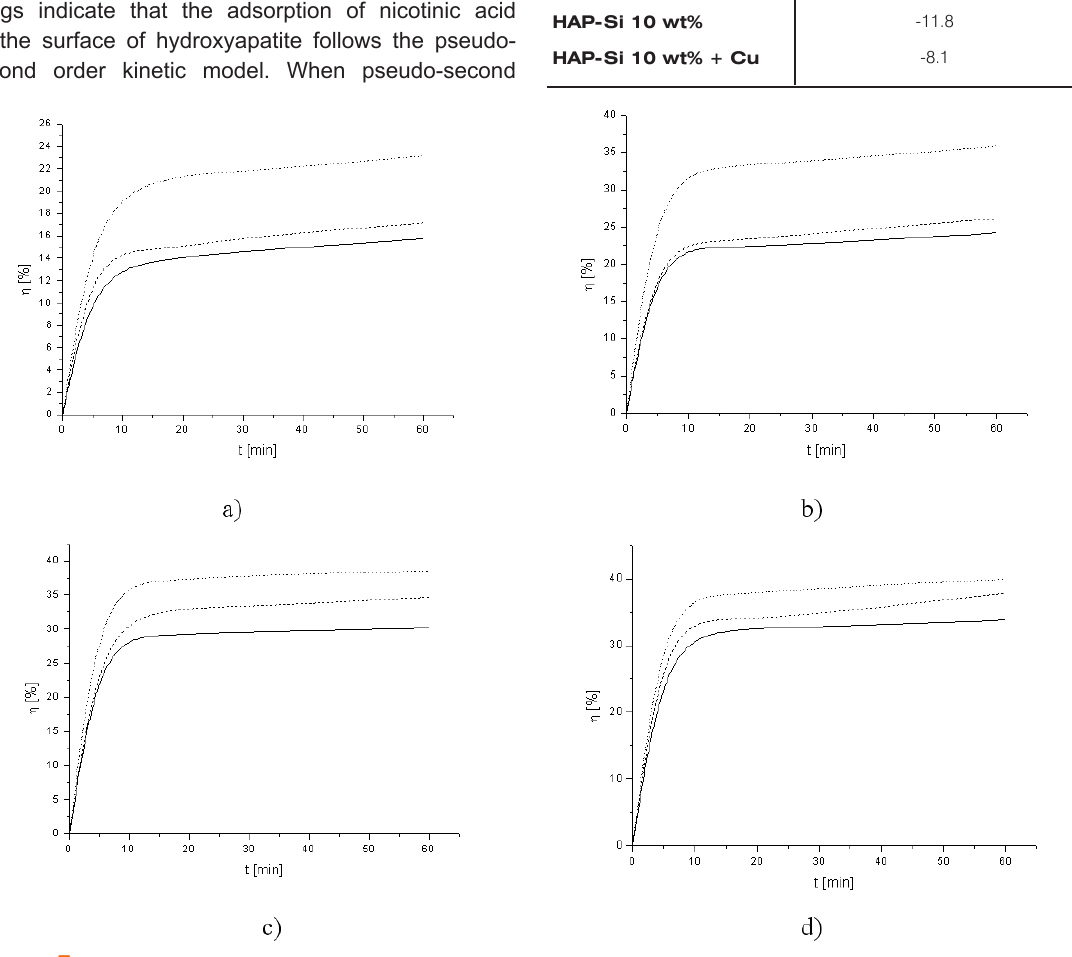
Figure 5. The adsorption efficiency of HAP (a), HAP-Si 5 wt% (b), HAP-Si 10 wt% Si (c) and HAP-Si 10 wt% Si doped with copper(d) at 15 o C (short dotted line), 20 o C (dashed line) and 30 o C ( solid